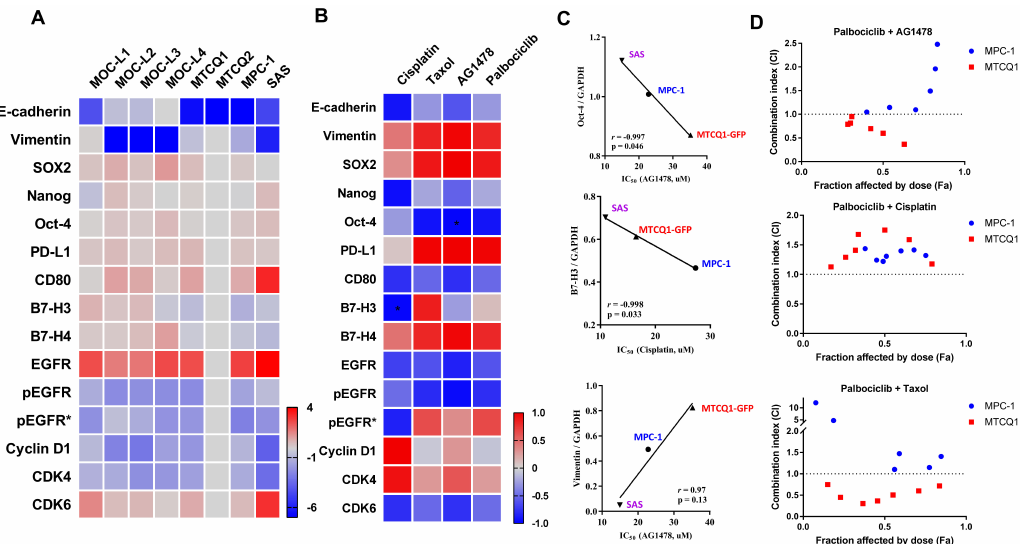
Figure 4. Gene expression profiling and the testing of the e ff ects of various drugs on OSCC cells. ( A ) The heatmap of the normalized protein expression values (log 2 transformed) for the various cell lines. Right lower, gradient bar. ( B ) The heatmap of correlation values ( γ ) according to the IC 50 of the drugs used and protein expression values for MPC-1, MTCQ1, and SAS cells. Right lower, gradient bar. pEGFR*, normalize pEGFR to EGFR. * p < 0.05. ( C ) Representative correlation analysis between the IC 50 of drugs used and protein expression in various cells. ( D ) Analysis of the synergism between palbociclib and AG1478, and between cisplatin and taxol by means of CI for MPC-1 and MTCQ1